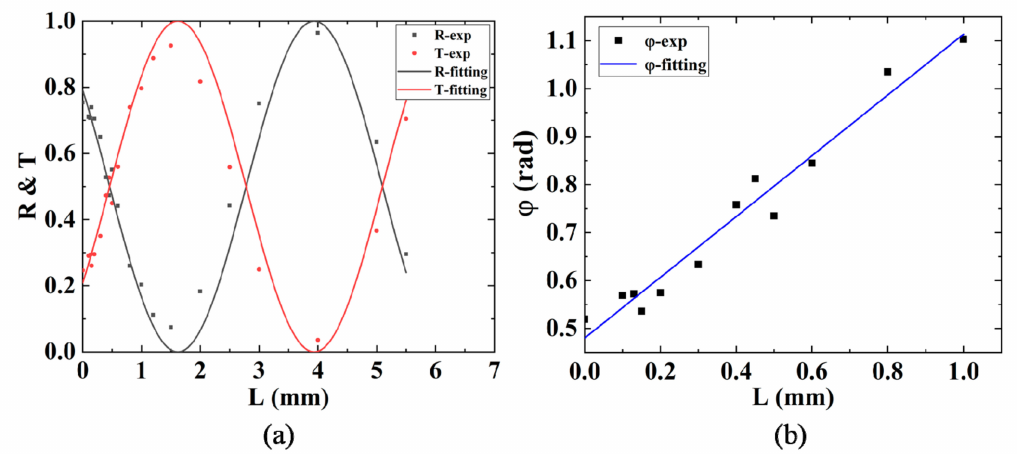
Figure 3. Experimental reflectivity and transmission of fabricated DCs. ( a ) Measured reflectivity R and transmission T of the DCs with di ff erent interaction length L at fixed interaction distance d = 8 µ m as well as fitting curves for R and T . ( b ) Fitting for linear relation between coupling phase ϕ and interaction length L ranging from 0–1